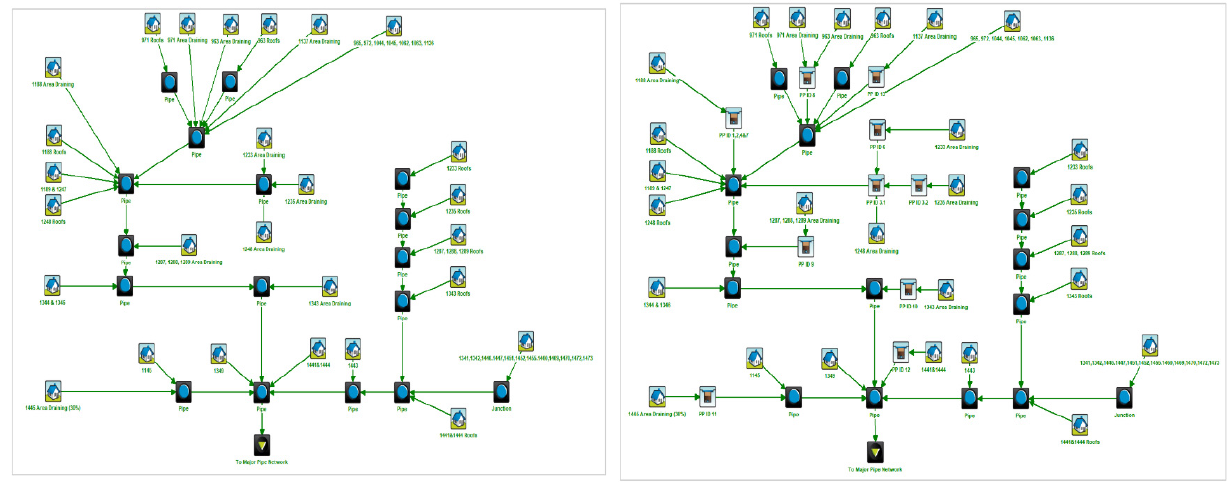
Figure 4. MUSIC model for base case ( left ) and with implementation of permeable pavements ( right ). Inputs to the MUSIC model comprised urban nodes to represent the areas of roads, footpaths, and other impervious surfaces draining into pavements indicated as “area drain- ing” within the model. The media infiltration node represents the permeable pavements and junction nodes indicate the locations of pits, pipes and areas of confluence. These nodes were connected by primary linkages to indicate the path of drainage as either surface flow and/or pipe flow. Sub catchments were lumped if they were found to drain into